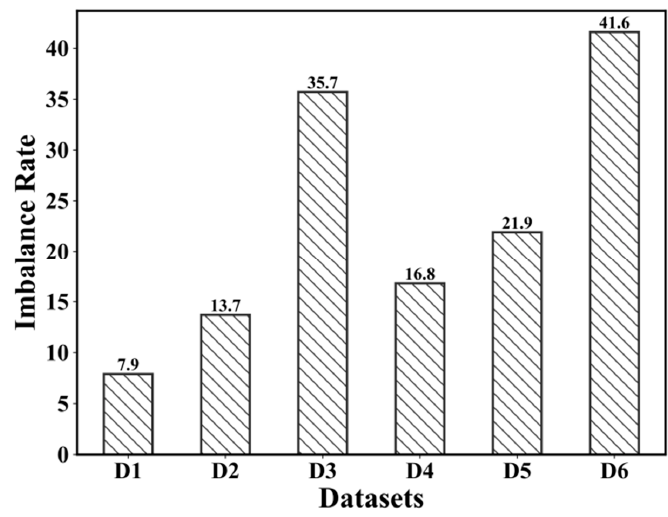
Figure 4. Class imbalance rate on each data set.